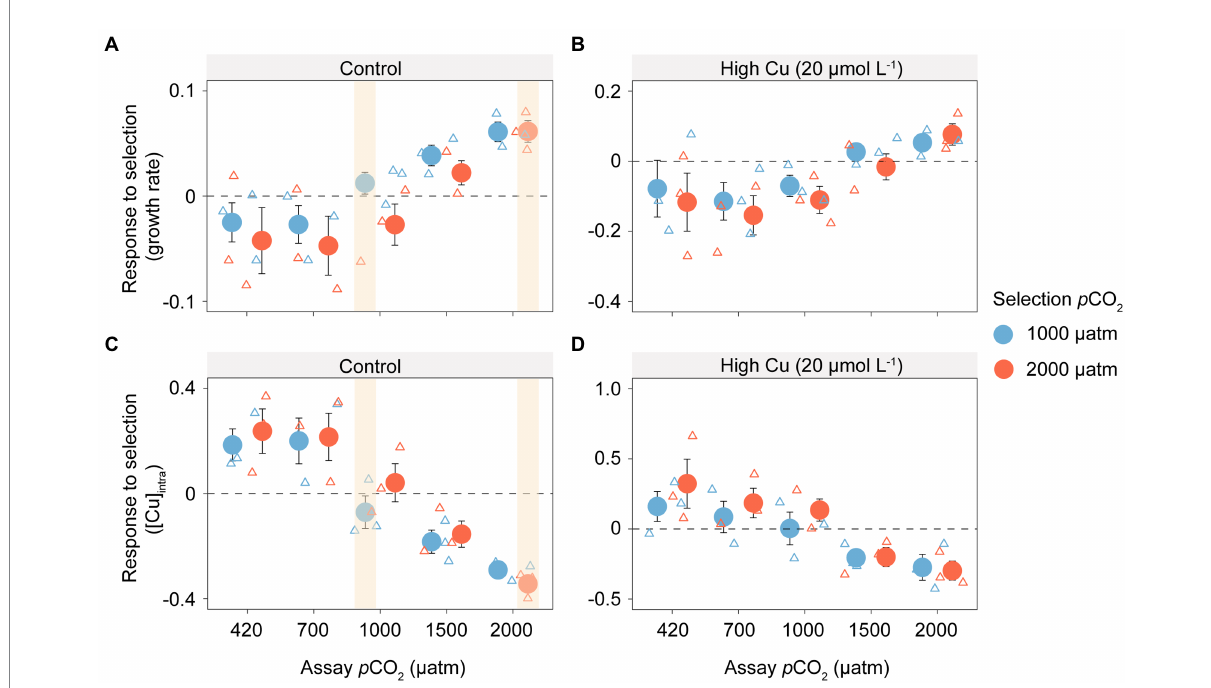
FIGURE 2 Growth rates and intracellular copper concentration of T. pseudonana in the shift experiment under elevated p CO 2 with or without additive copper exposure. Box plots show the response to selection measured as the difference in growth rate (day − 1 ) without (A) or with (B) copper exposure and intracellular copper concentration ([Cu] intro ) without (C) or with (D) copper exposure, between populations evolved to elevated CO 2 (1,000 and 2,000 μ atm) and the evolved control populations (420 μ atm), under the same environmental conditions. The direct response to selection is highlighted in yellow and compares the population growth rate of a population evolved in the selection environment with the plastic response of a control population to that same environment. The dashed line shows the average growth rate of the evolved control populations in each environment (indicated on x axis and panel labels). Distance from the dashed line shows the difference in responses between the evolved populations and the evolved control in the same